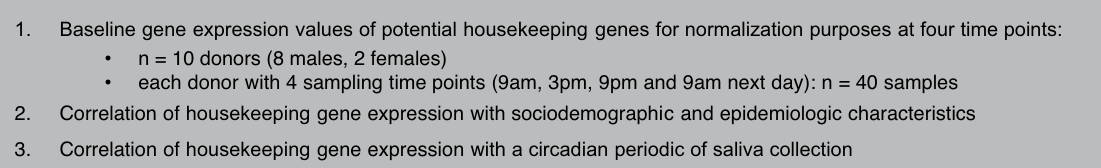
Figure 1. Overview of the samples, study design and tasks I–III description. The inserted table shows the number of samples used in the different tasks as well as the time points of